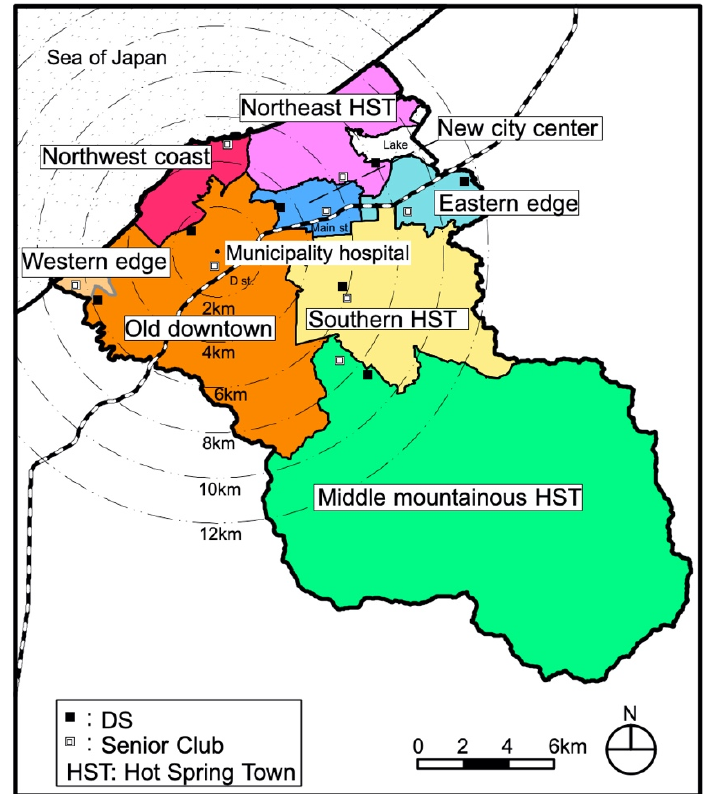
Figure 4. Eight target districts in Kaga (unit: kilometers).